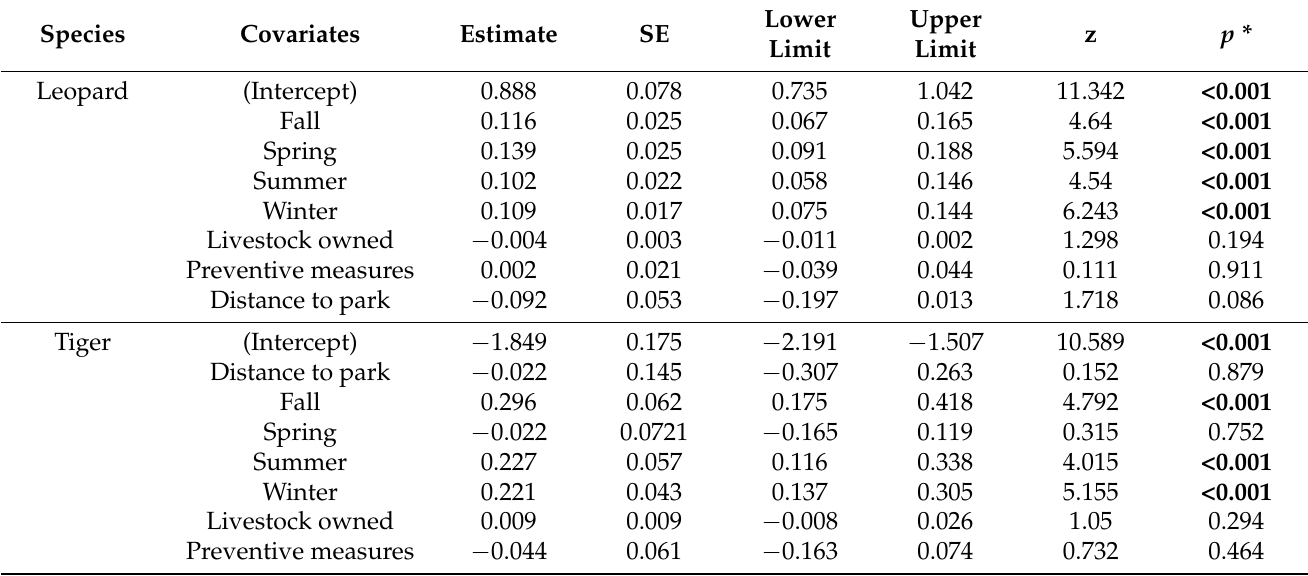
Table 3. Model-averaged parameter estimates and lower and upper 95% confidence limits describing livestock depredated by leopards and tigers, Bardia National Park, Nepal. Parameter estimates were averaged from all models reported in Table 2. * Significant effects are in